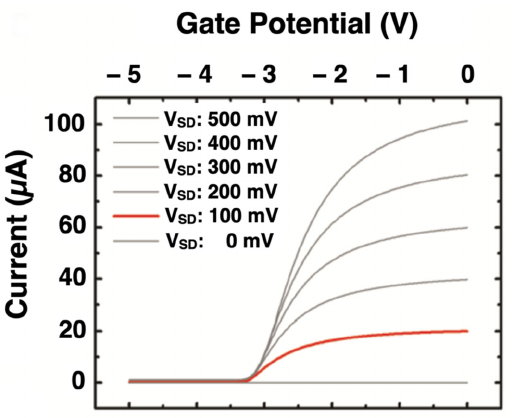
Figure 6. A plot of the source–drain current, as a function of gate–drain potential (reproduced with permission from [16]; published by Wiley Online Library, 2012).